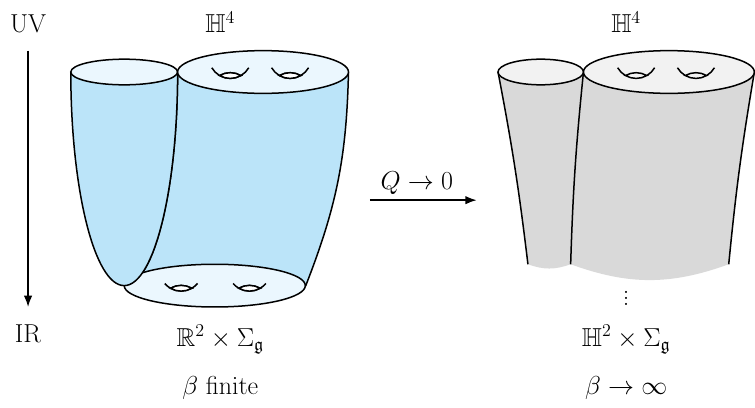
Figure 1 . A schematic depiction of the Euclidean black saddle solution (2.13) and the universal black hole (2.11). In the limit Q → 0 the periodicity of the τ coordinate becomes infinite and the IR region acquires the metric on H 2 × Σ g which can then be analytically continued to the near-horizon AdS 2 × Σ g metric of the black hole. Both classes of solutions are asymptotically locally H 4 in the UV region with S 1 × Σ g